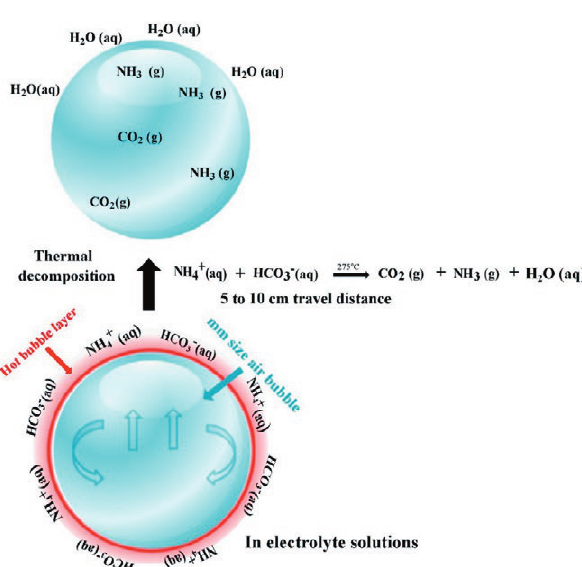
Figure 1. Schematic diagram of BCE thermal decomposition using a hot-air bubble layer. (Reprinted with permission from Ref. 3. Copyright 2015 American Chemical